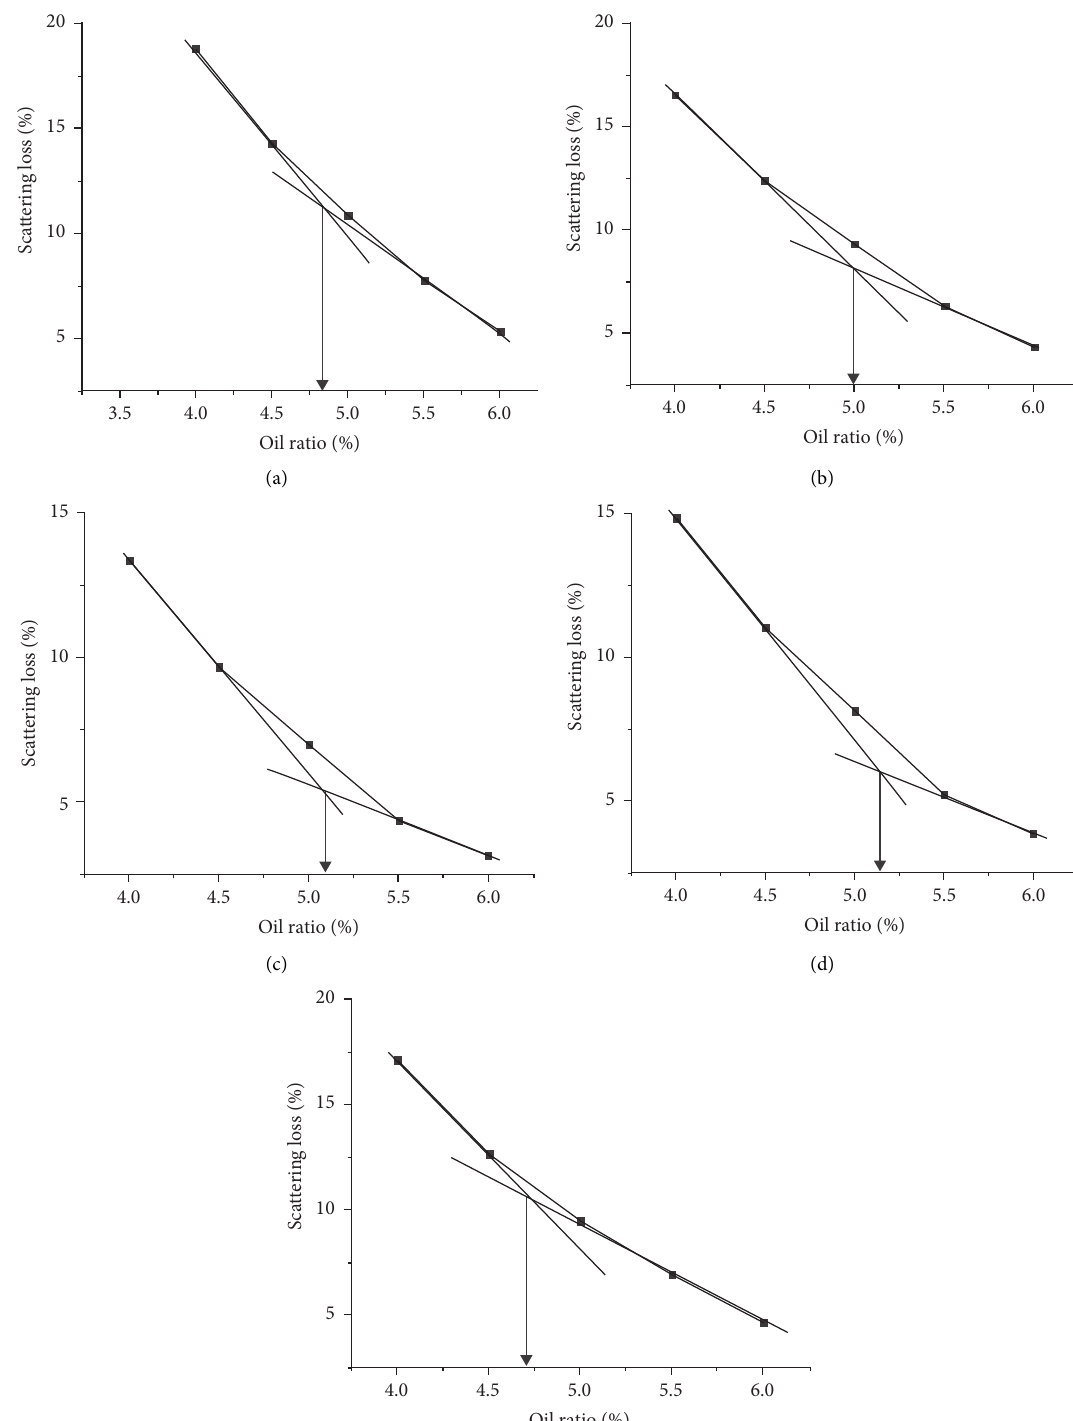
Figure 4: Scatter loss-whetstone ratio diagram. (a) Float loss-oil-aggregate ratio diagram of fiberless SBS. (b) Float loss-oil-petroleum ratio diagram of 0.15% fiber SBS. (c) Float loss-oil-petroleum ratio diagram of 0.25% fiber SBS. (d) Float loss-oil-petroleum ratio diagram of 0.35% fiber SBS. (e) TPS float loss-oil-petroleum ratio